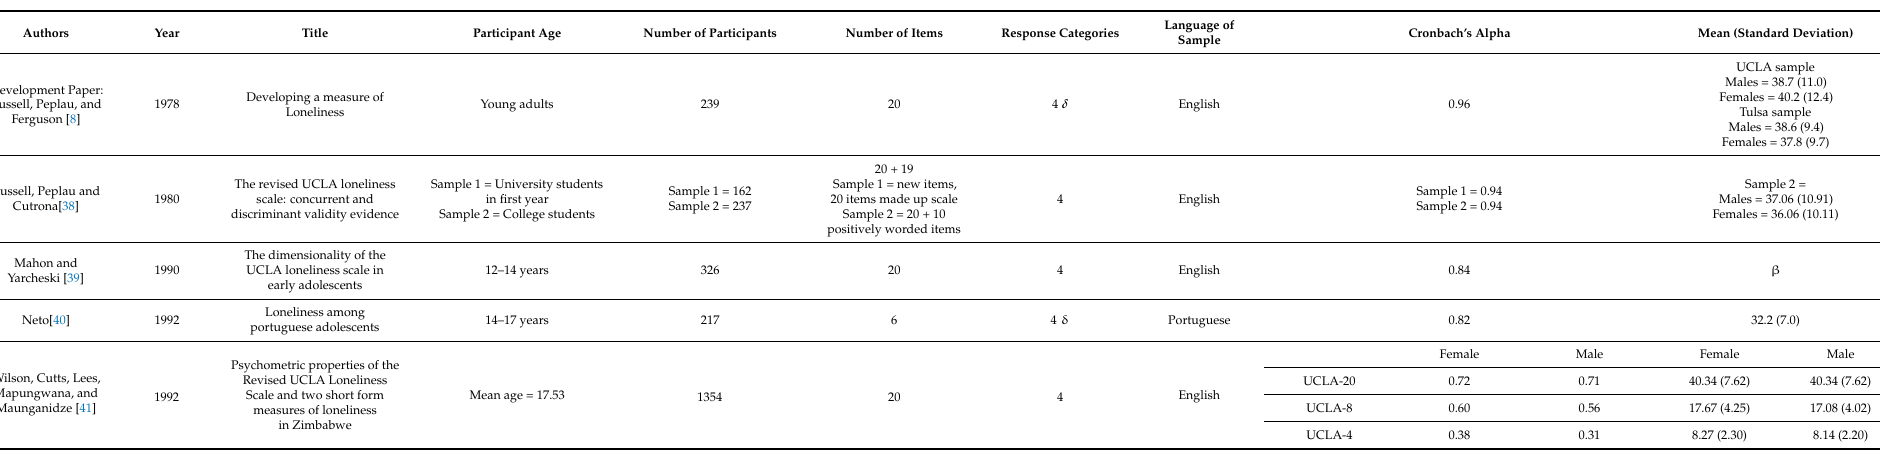
Table 3. Subsequent research papers investigating the psychometric properties of the UCLA Loneliness